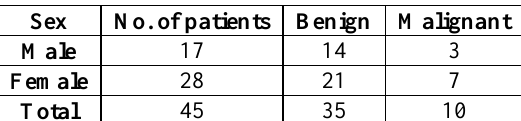
Table 1: Numbers of patients with benign and malignant tumors